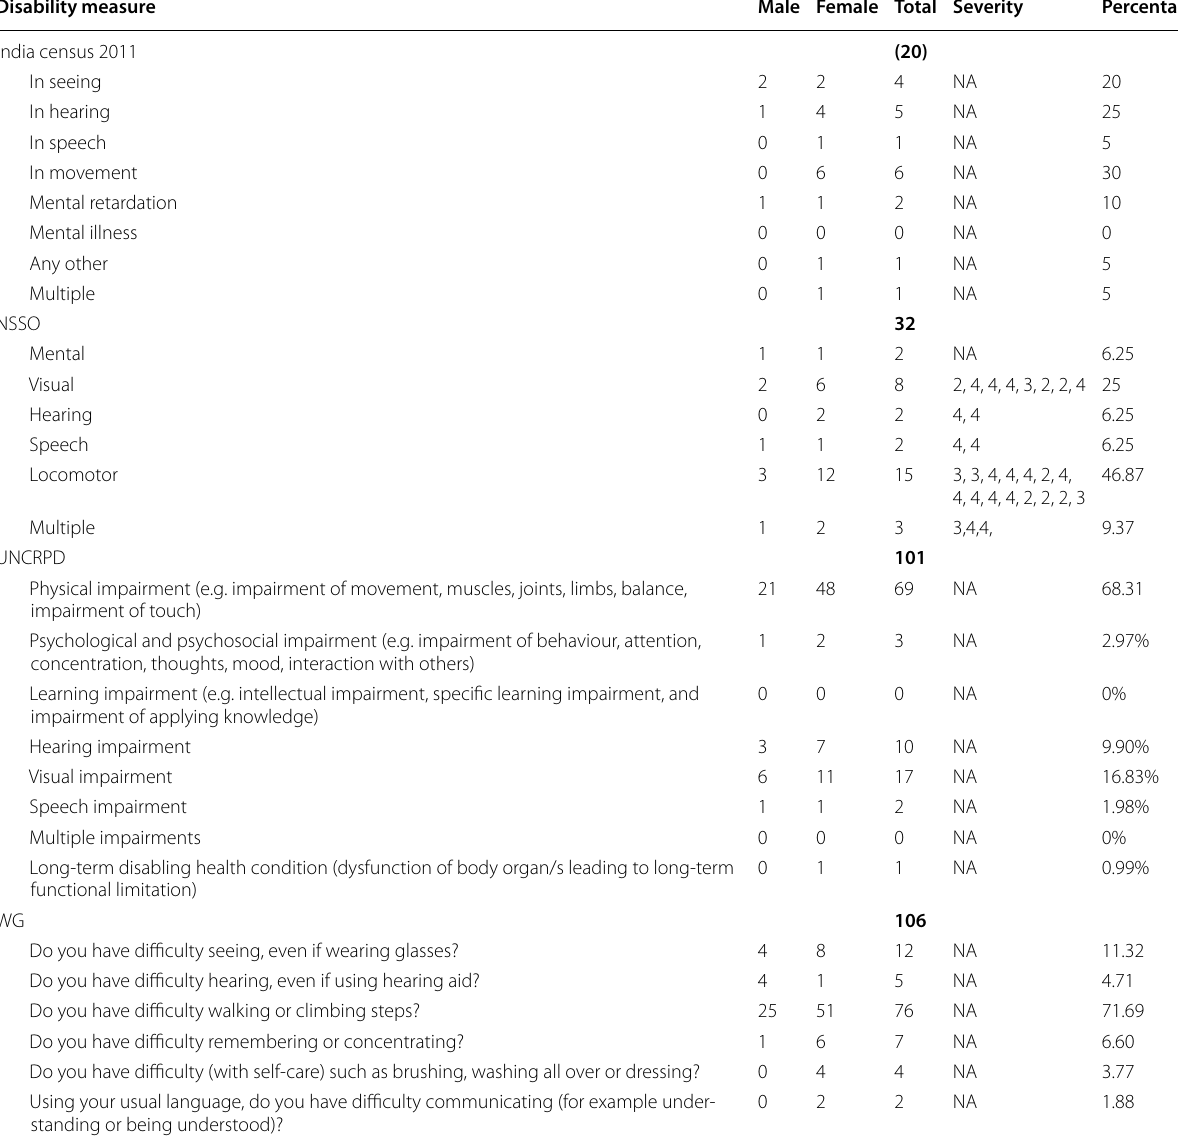
NSSO , National Sample Survey Organization; UNCRPD , United Nations Convention on the Rights of the Persons with Disabilities; WG , Washington group; NA , not applicable